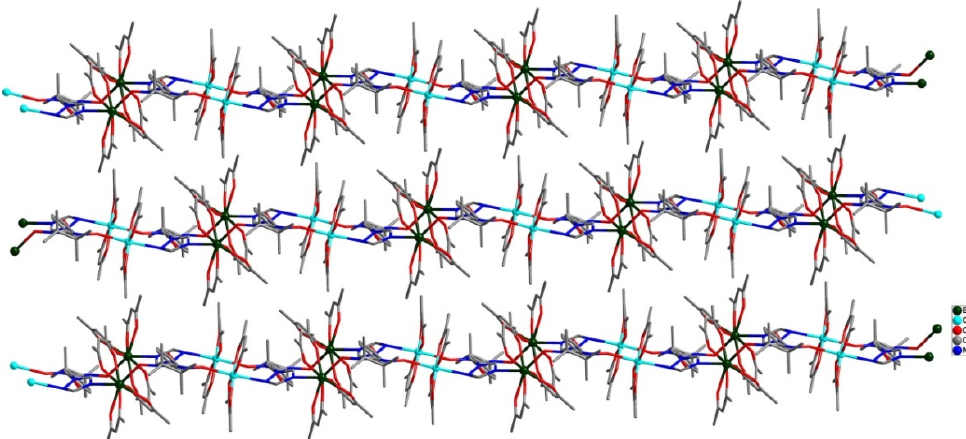
Figure 6. Crystal packing of [ErCu(hfac) 5 NIT-Ph- p -OCH 2 trz·0.5C 6 H 14 ] n chains. Reprinted from [126], copyright 2020, with permission from Elsevier.